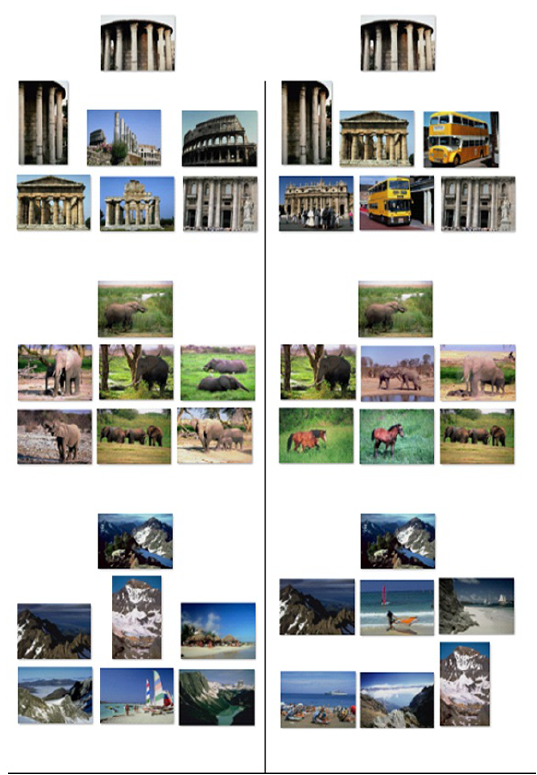
Fig. 9. Some snapshots of the results, Left column has semantic class association results, while Right column has K nearest neighbors result. Top image is the query image and bottom images are the retrieved images.